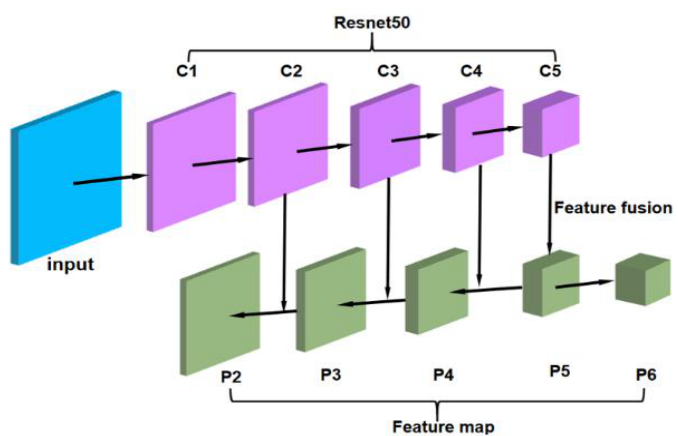
Figure 8. How RoI (region of interest) Align works.